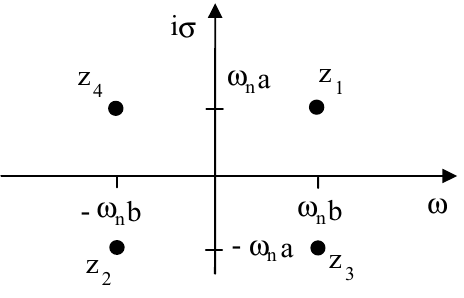
Fig. 5. Poles z 1 , z 2 , z 3 and z 4 for the hysteretic damping case.